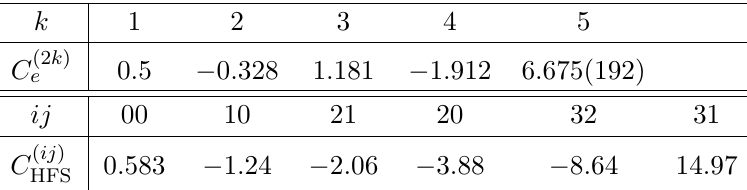
Figure 9 . The sensitivity of the probability distribution 1 / ( m t ) 0 P abc ((( m t ) est for on-shell top quark mass for n = 1 (dashed) and n = 3 (solid) on the parameters ( (cid:15), ω, η, ξ ) for 4 selected values with the others held fixed at ( (cid:15), ω, η, ξ ) = (0 . 1 , 1 , 0 . 1 , 2) .